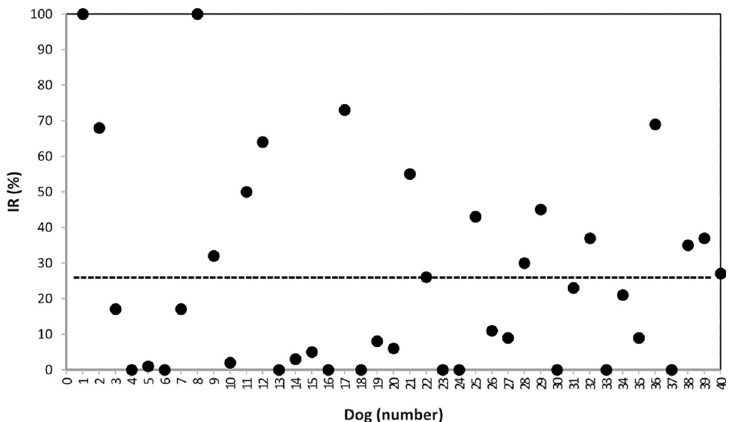
Fig 2. Intake Ratio [IR% = MDM/(MDM + MBP) x 100] of the MDM diet (based on Mechanically Deboned Chicken Meat) as compared with the MBP diet (based on Meat By-Products) for each dog (———Mean value).